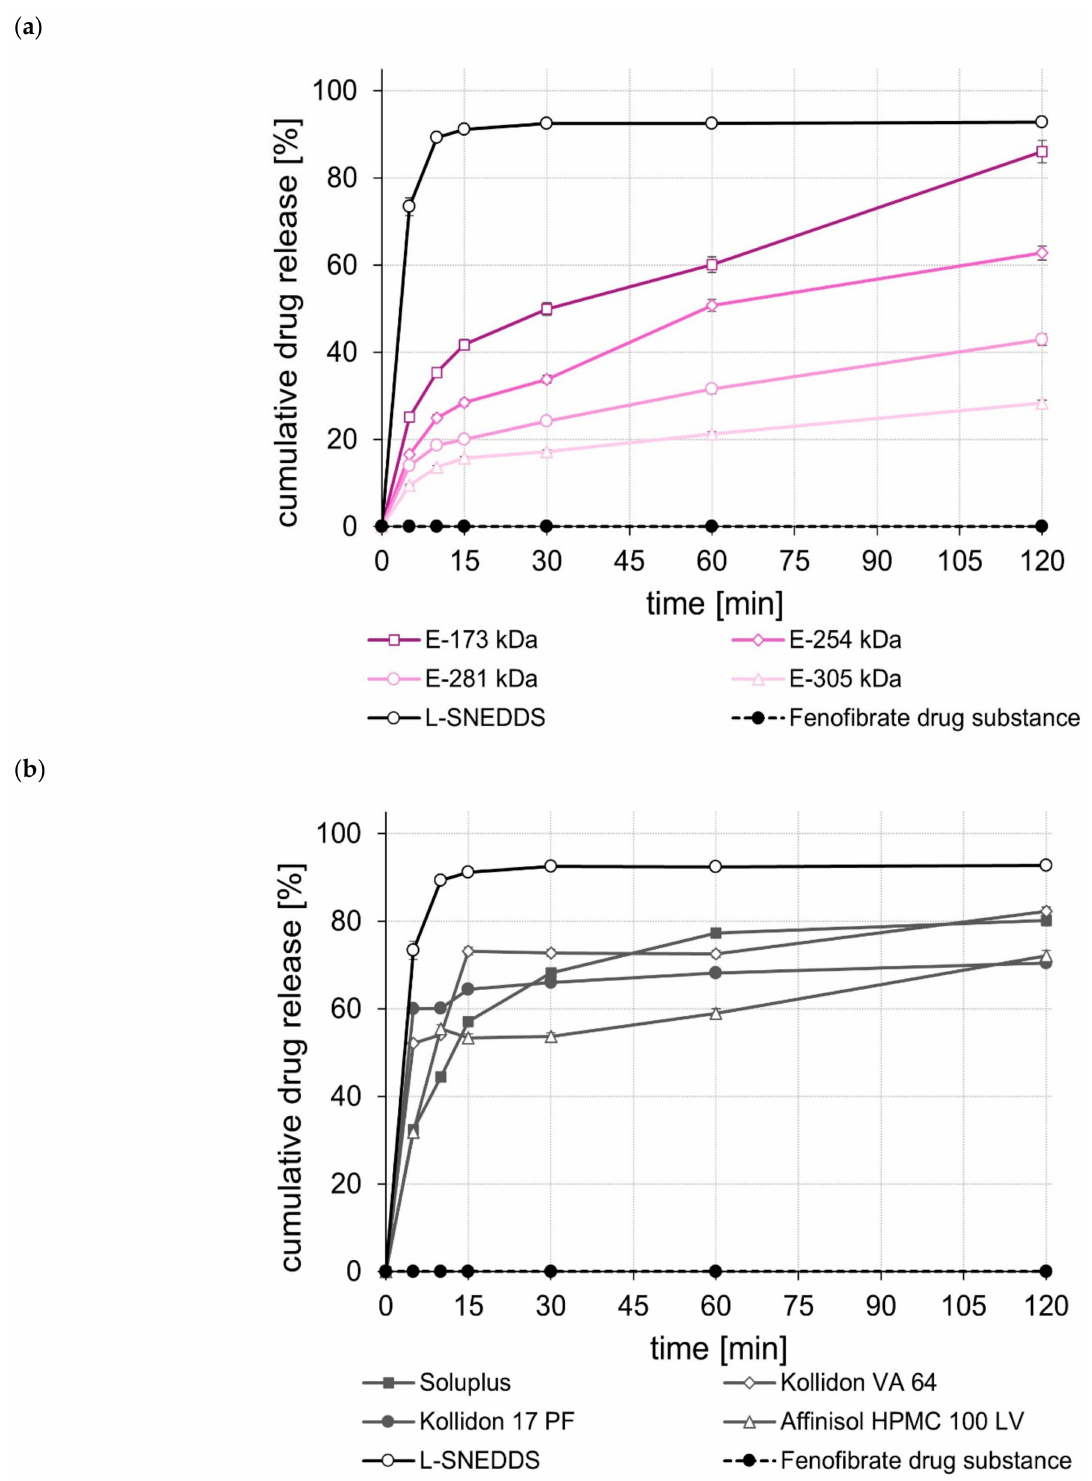
Figure 6. Dissolution profiles of the fenofibrate drug substance and fenofibrate L- and S-SNEDDS based on ModE ( a ), as well as the fenofibrate drug substance and fenofibrate L- and S-SNEDDS based on other marketed (co)polymers ( b ) after six months of storage at 30 ◦ C/65% RH in 500 mL 0.1 M HCl in USP apparatus II. Each value designates the mean ± S.D. ( n = 3). For the celecoxib S-SNEDDS, a marked decrease in the total amount of drug released was observed for the Kollidon ® 17 PF- and the E-305 kDa-based S-SNEDDS after only